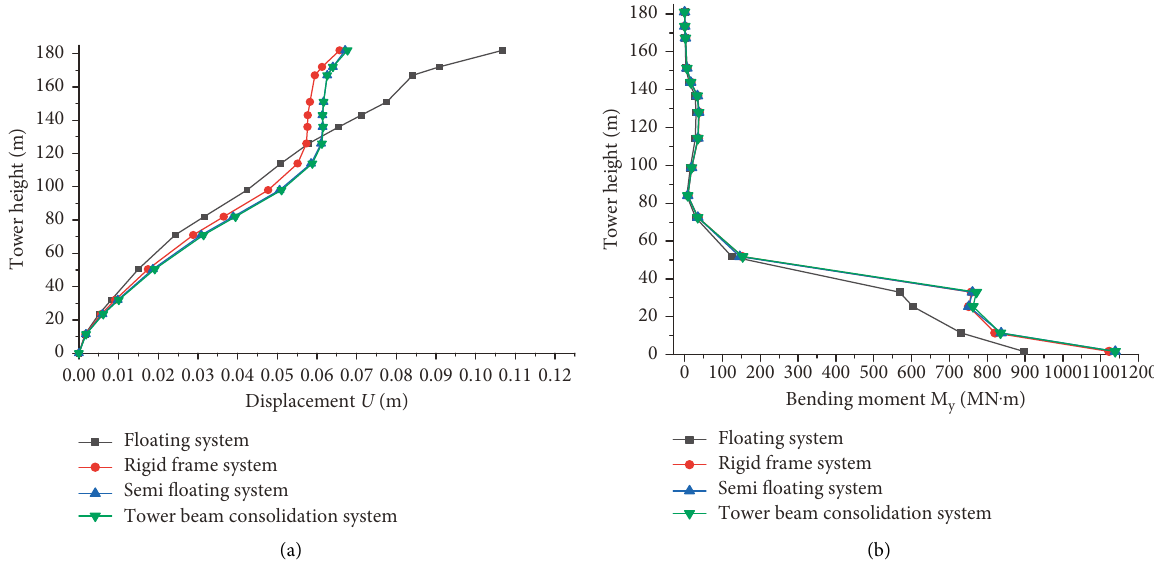
Figure 10: Distribution of maximum displacement U and maximum bending moment My along with the tower height for bridges of different structural systems under earthquake action. (a) Distribution of the maximum value of the bridge tower displacement and (b) distribution of the maximum value of the tower bending moment.